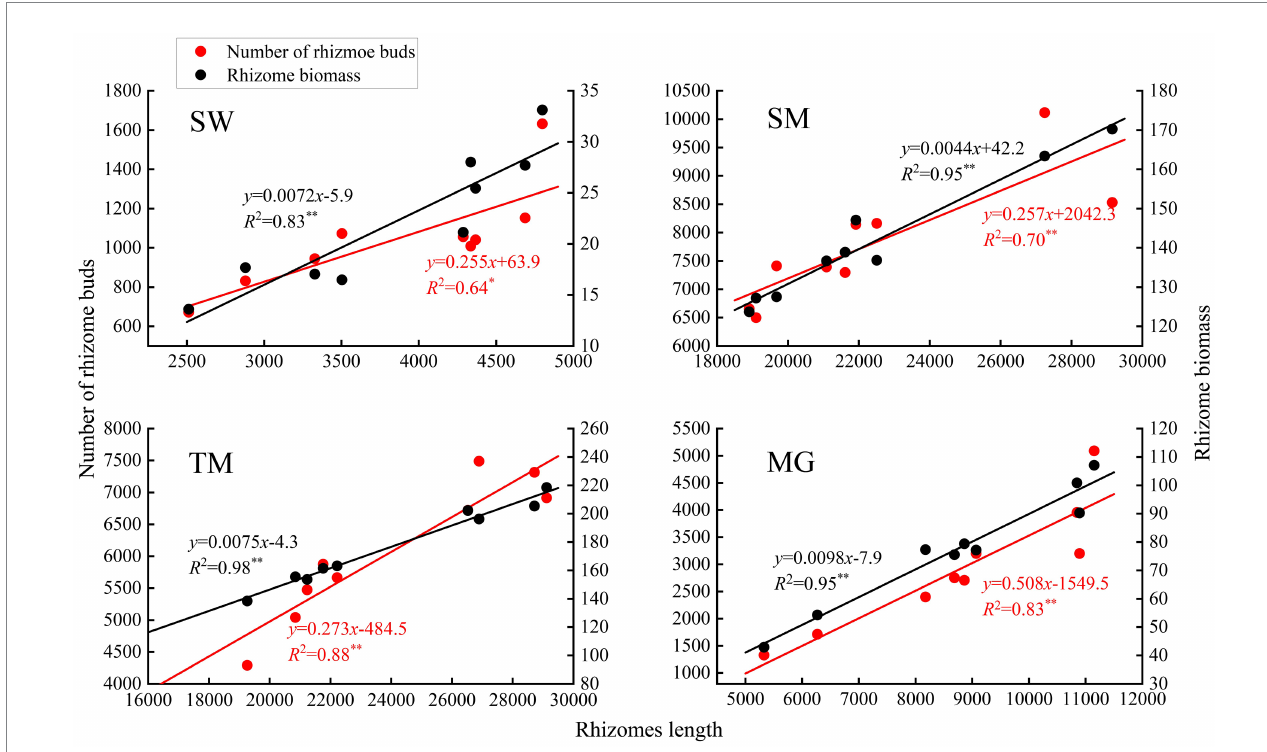
FIGURE 3 Regression of rhizome bud number, rhizome biomass and rhizomes length of D. angustifolia in four